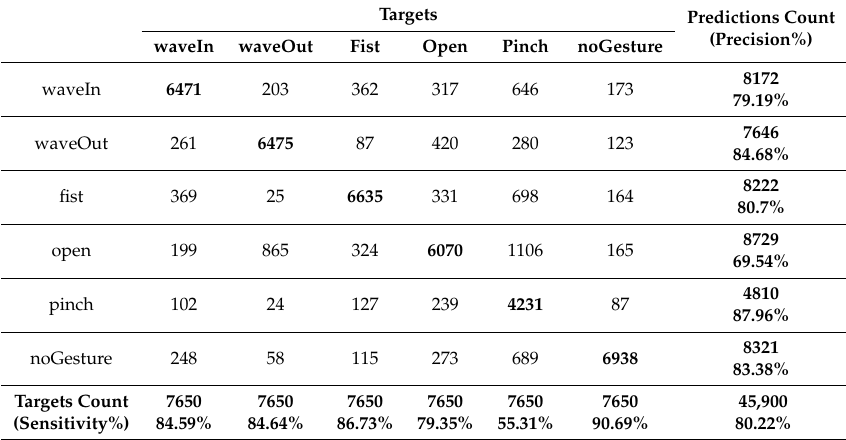
Table A8. Confusion matrix for experiment 4 . Synchronization gestures ( sync = 1 ) .